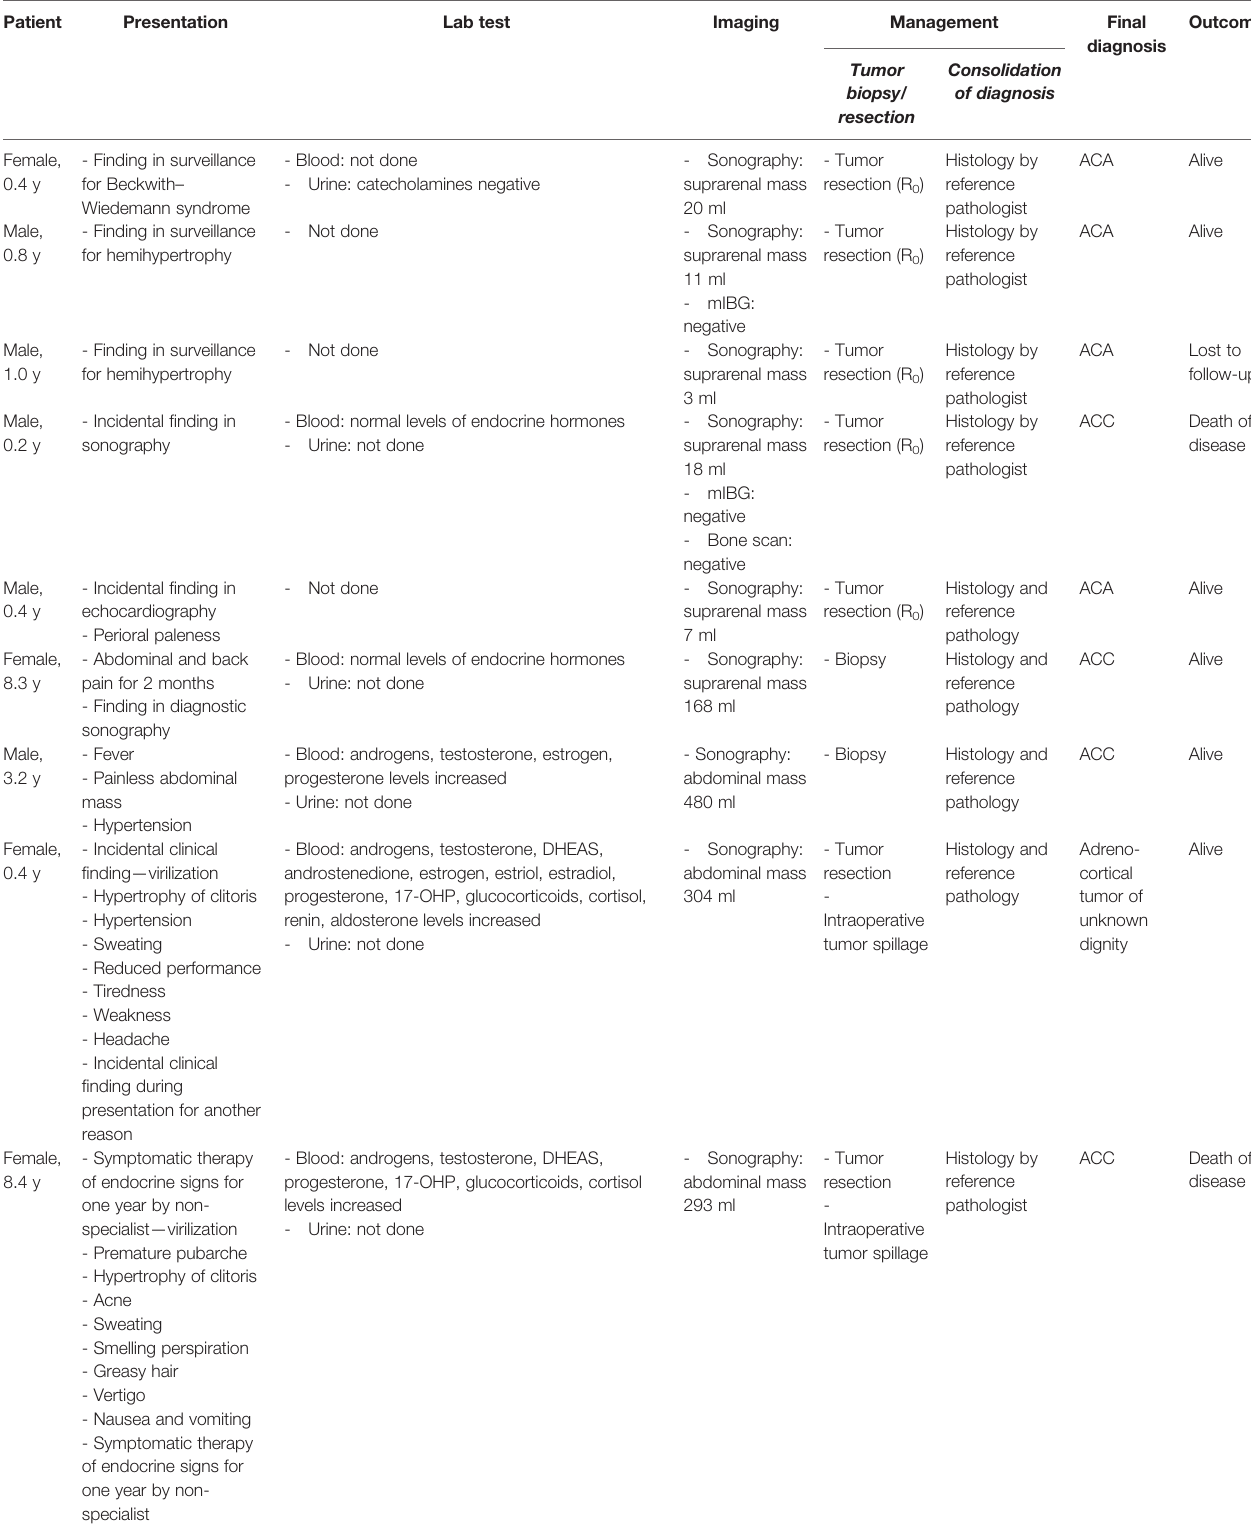
TABLE 1 | Demographic details and clinical presentation in 10 children and adolescents with adrenocortical tumors initially mistaken as